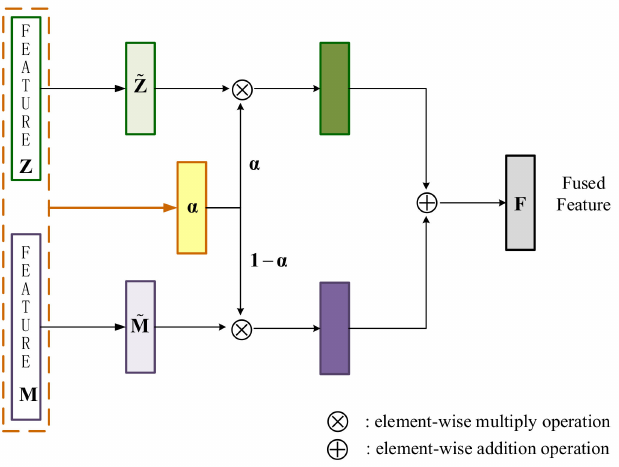
Figure 4. Flowchart of the proposed fusion